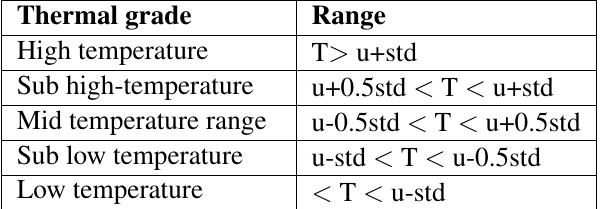
Table 2 Classification of heat island